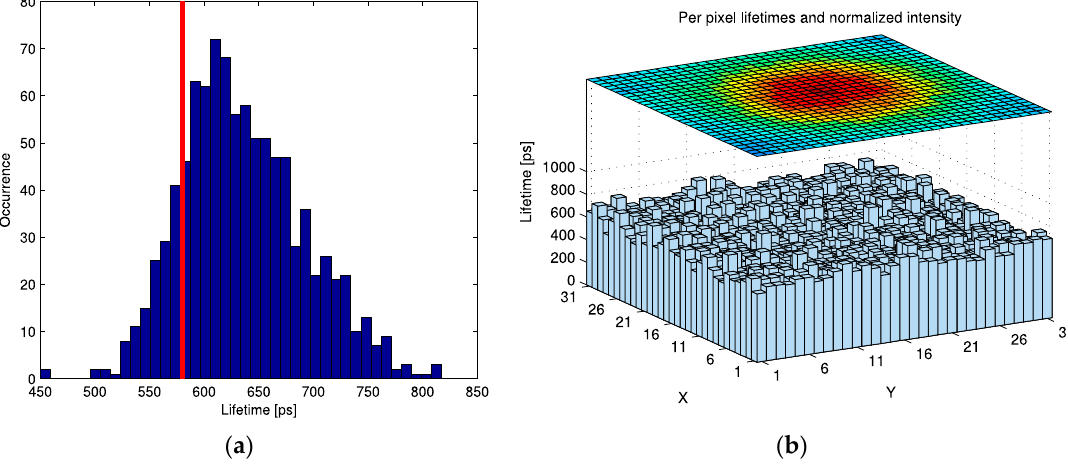
Figure 19. ( a ) FLIM results show extracted lifetimes distribution of 31 × 31 pixels compared to reference lifetime of 40 µM ICG in milk (red). ( b ) shows the comparison of intensity and lifetime per pixel.